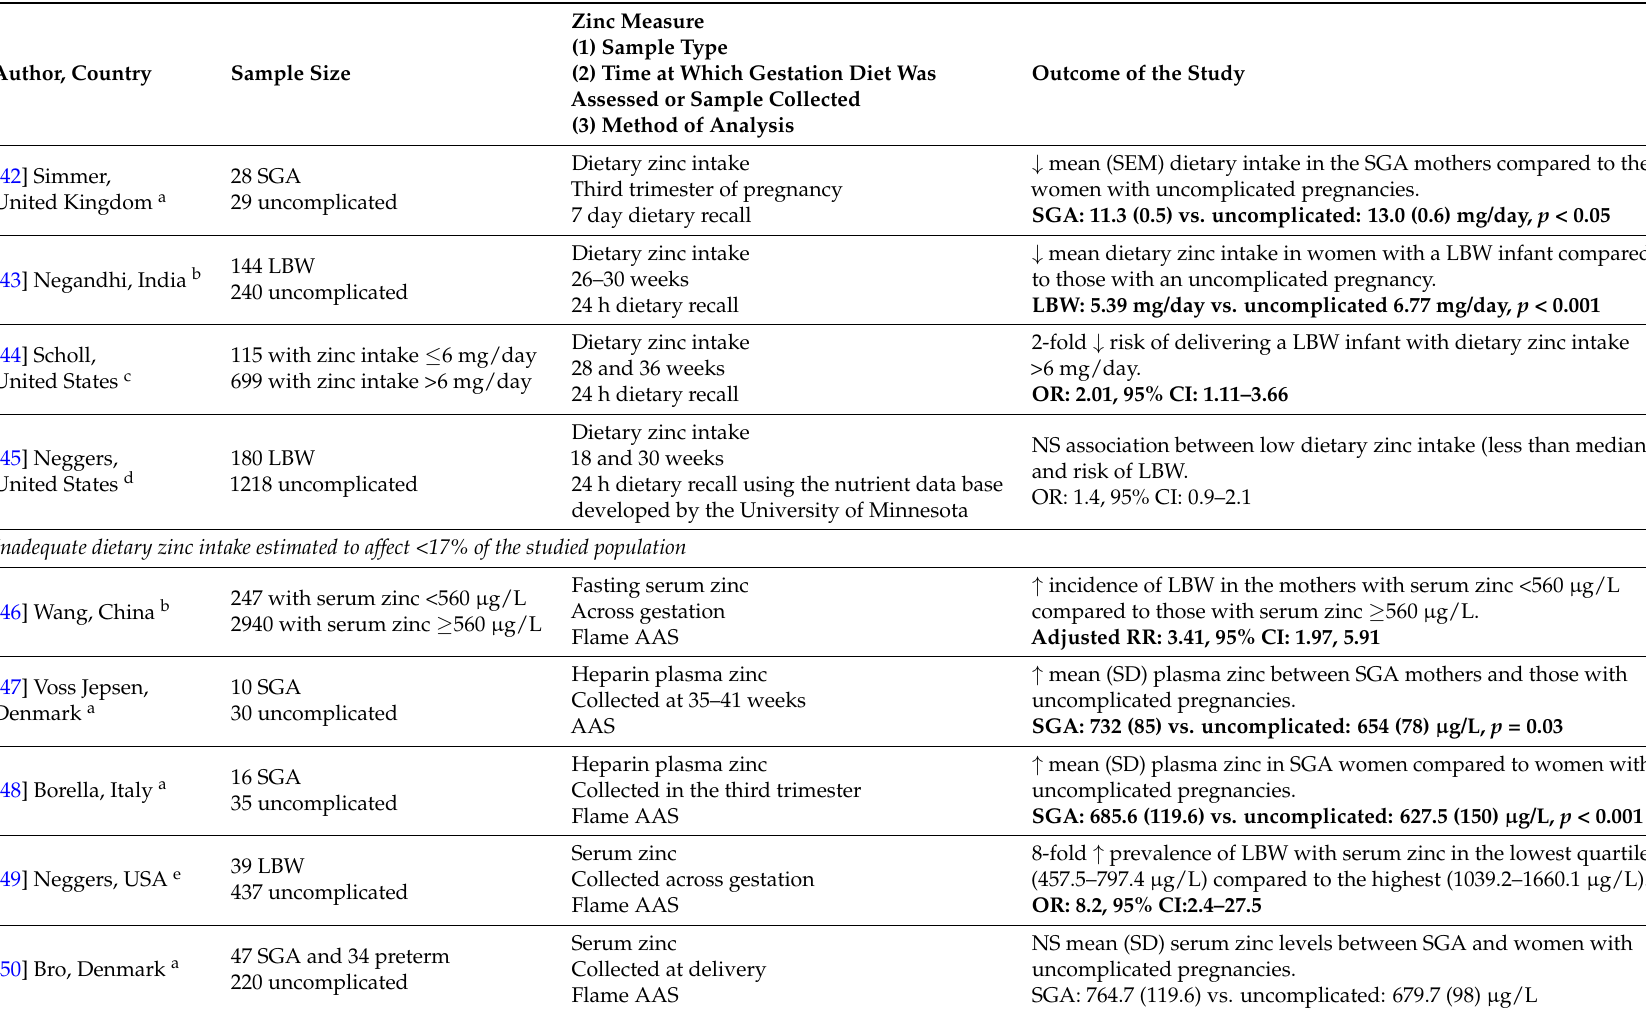
Table 1. Included studies assessing maternal zinc status and birthweight.